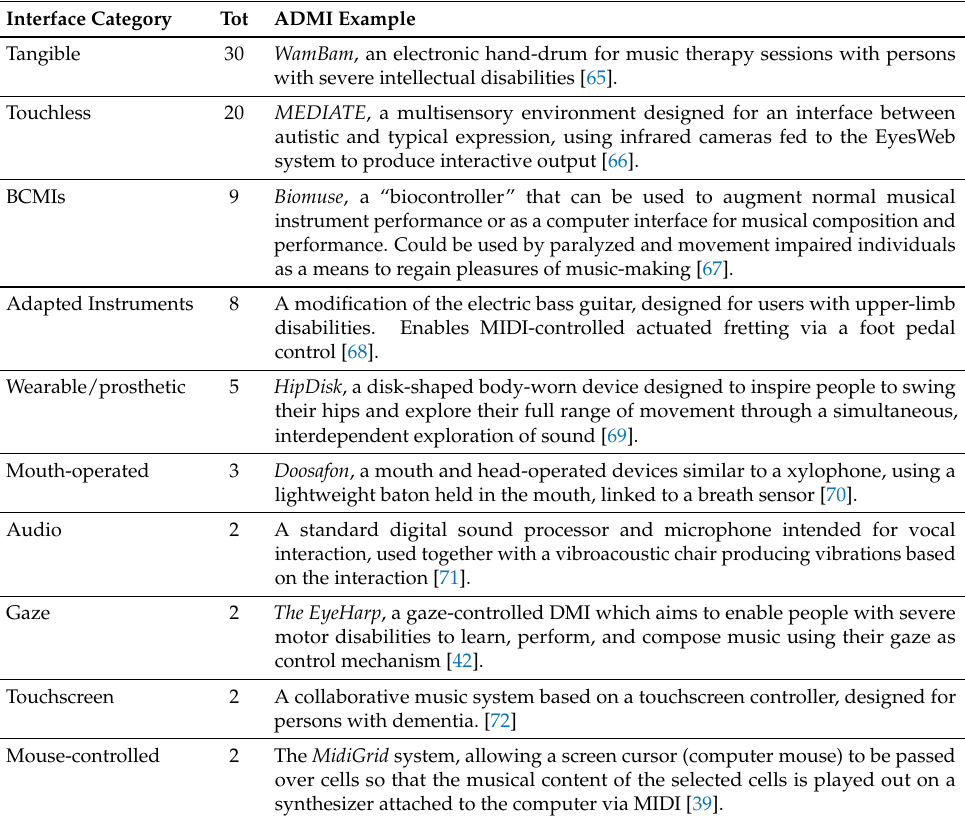
Figure 4. ADMIs per control interface category. Categories defined by main mode of interaction. Table 3. Control interface categories defined by main mode of interaction. Numbers correspond to the total number of ADMIs belonging to respective interface